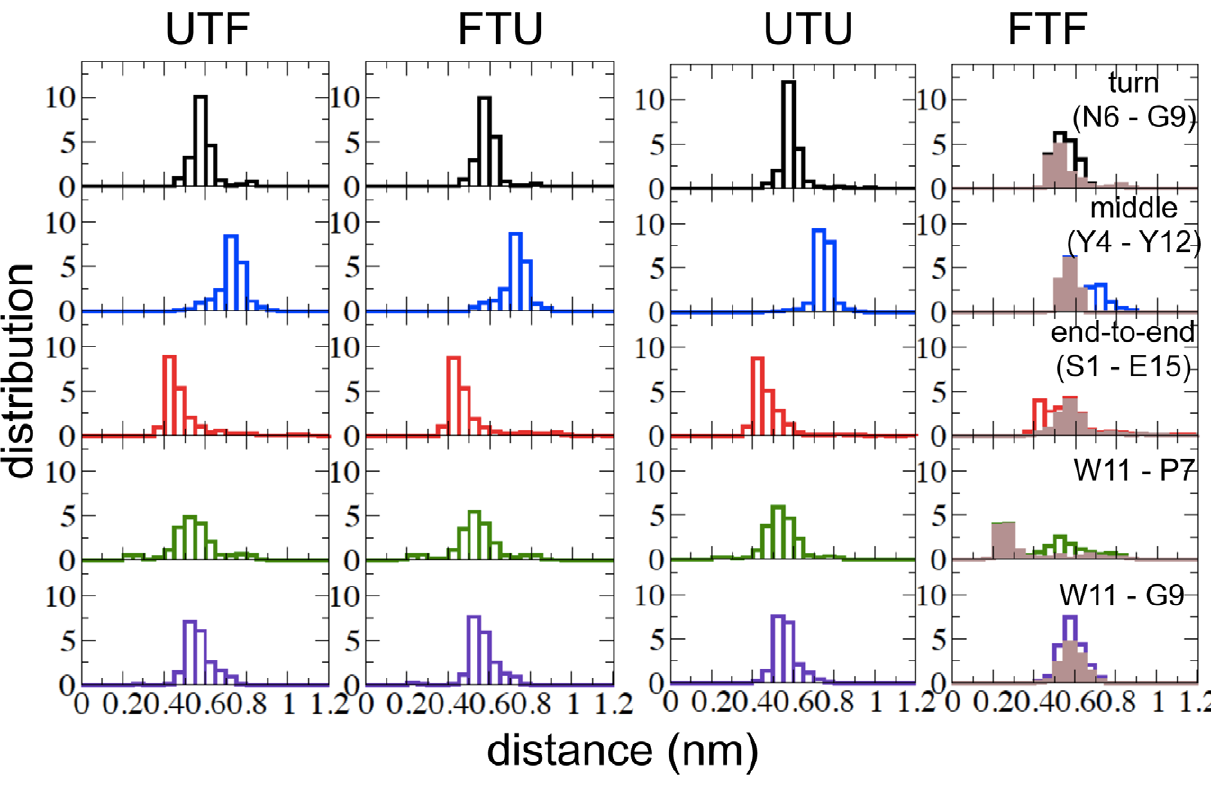
Figure 6. Distribution of various topological features in U-TS-F, F-TS-U, U-TS-U and F-TS-F subpopulations of the TSE of Peptide 1. Distributions of the distance between the C- a atoms of the residues N6-G9 (first row), Y4-Y12 (second row), S1-E15 (third row). Distributions of the minimum distances between the atoms of the W11 sidechain and the atoms of the sidechain of two turn residues, namely P7 (fourth row) and G9 (fifth row). The F-TS-F subpopulation shown in brown color corresponds to the structures with middle backbone contacts formed.